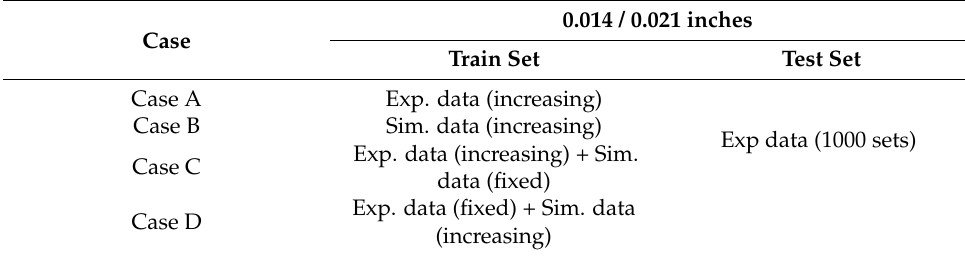
Figure 8. Process overview of direct transfer learning from dynamics model to test bench. Table 5. Data composition of four validation